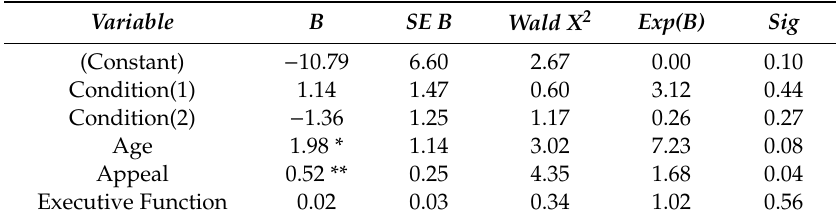
Table 2. Logistic Regression Results for Heavy Bunny